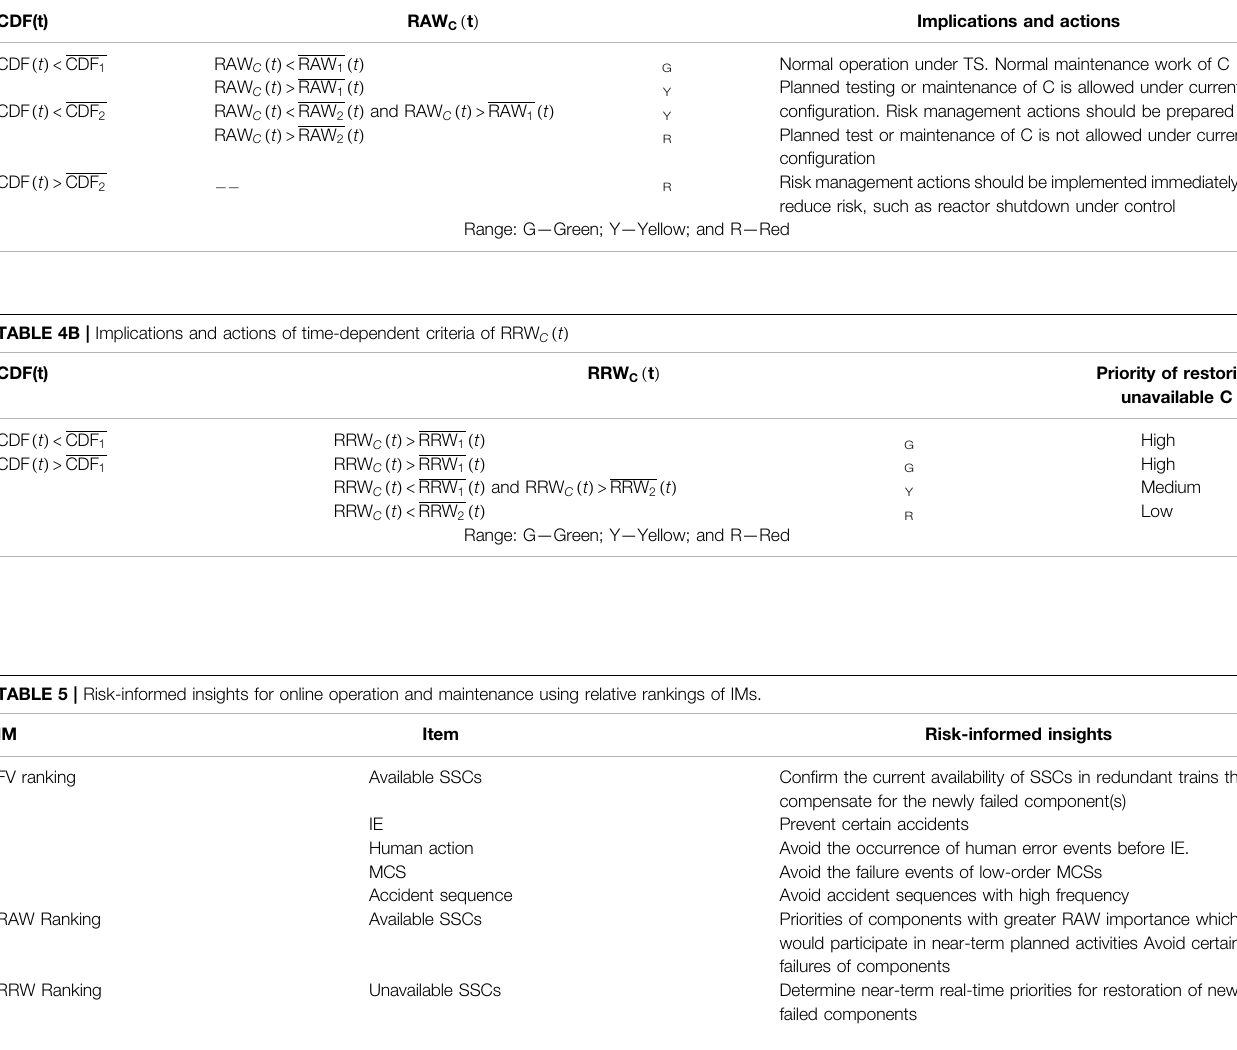
TABLE 4A | Implications and actions of time-dependent criteria of RAW C ( t ) CDF(t)